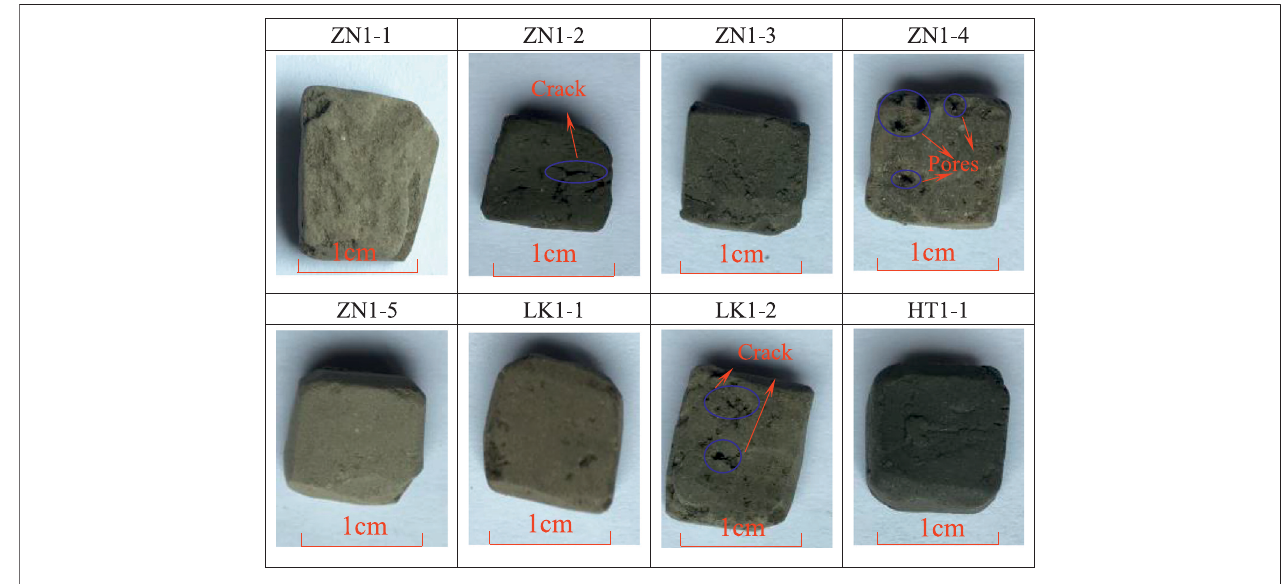
FIGURE 1 | The experimental samples of different sediments.